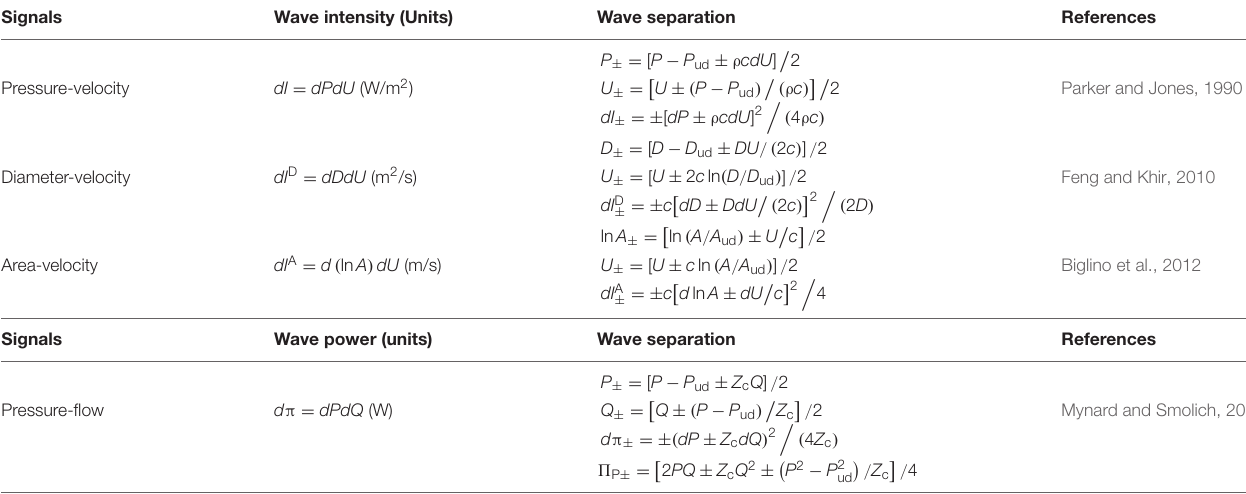
TABLE 1 | Variations of wave intensity/power and wave